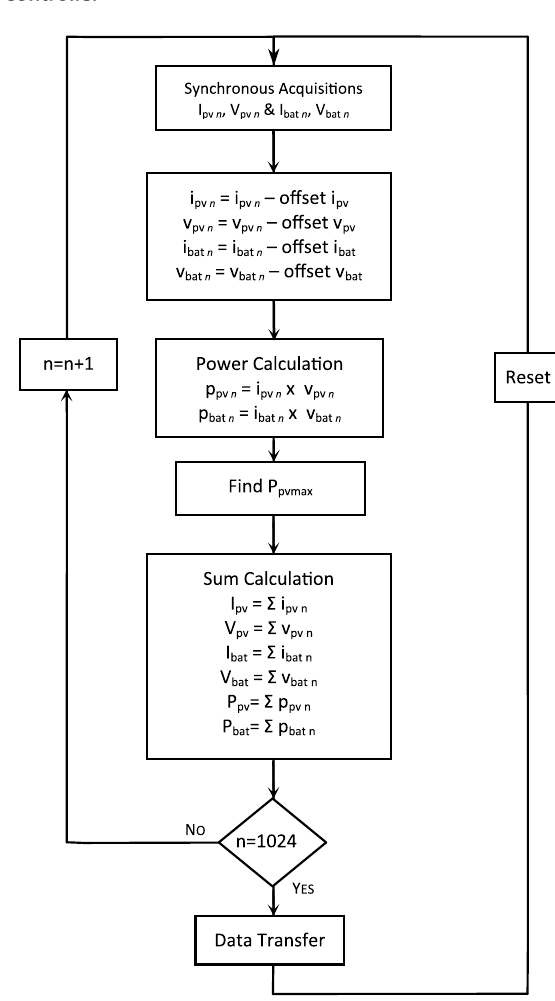
Fig. 8. Block diagram of the digital acquisition